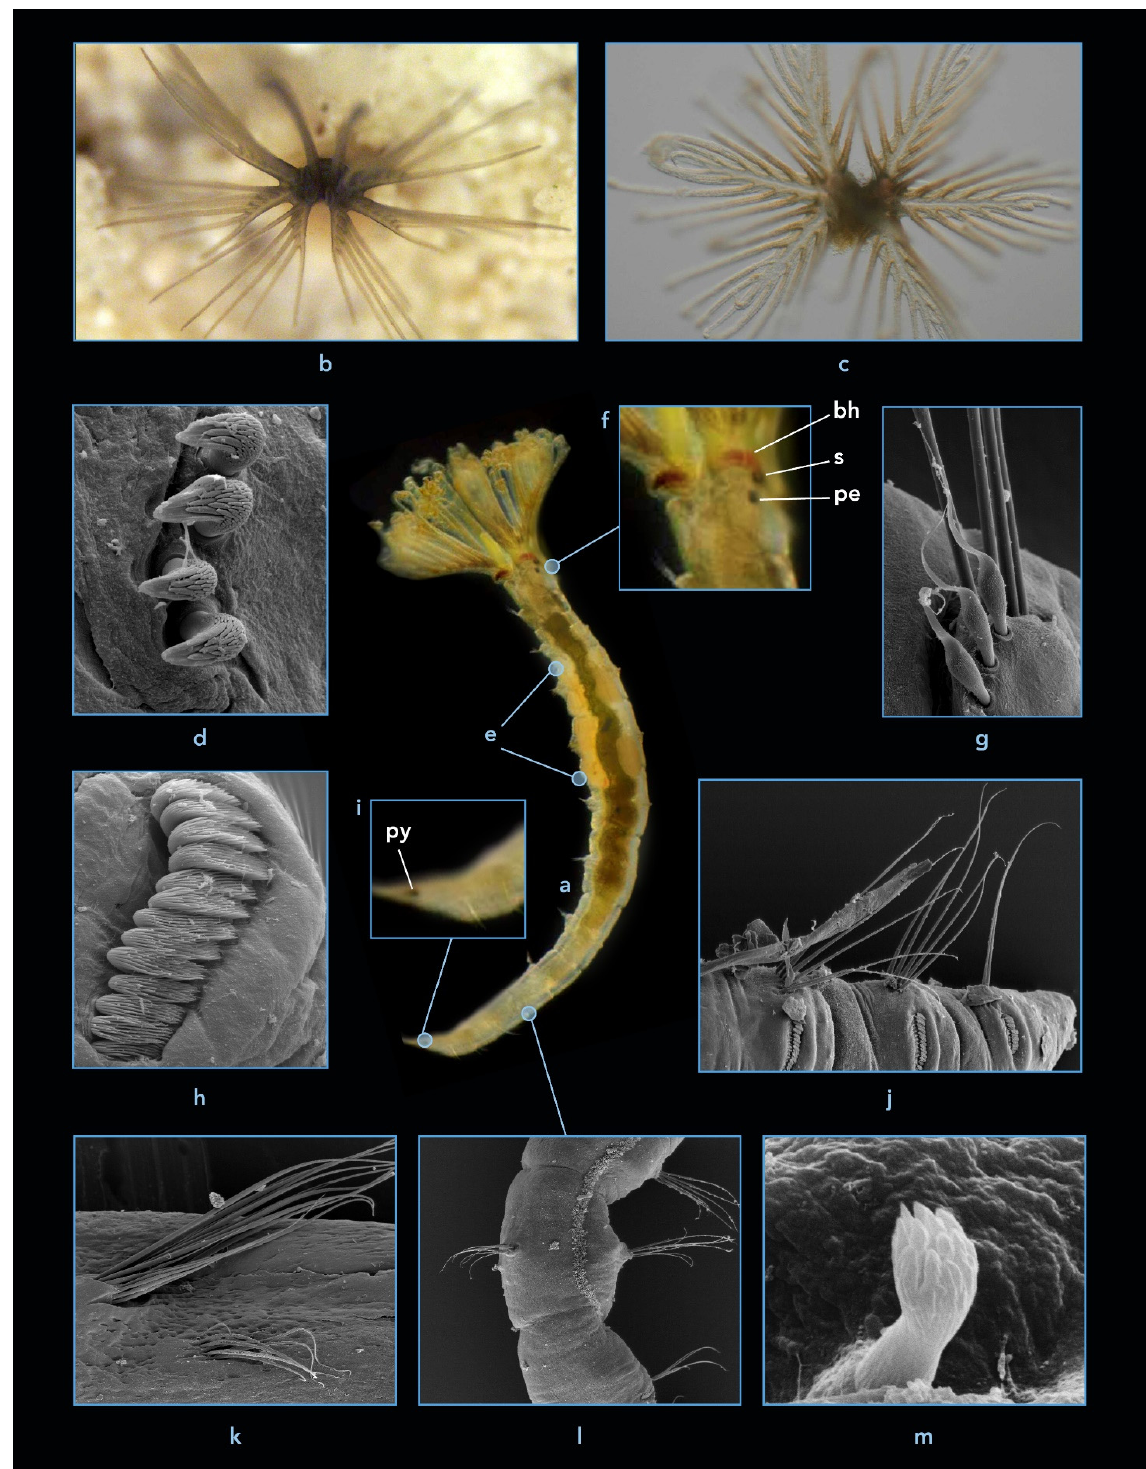
Figure 8. Main diagnostic characters for members of Fabriciidae. ( a ) Fabricia stellaris , dorsal view; ( b ) Pectinated radiolar branching pattern, Manayunkia athalassia ; ( c ) Bi-pectinated radiolar branching pattern, F. stellaris ; ( d ) Thoracic uncini of Manayunkia zenkewitschii ; ( e) Gamete bearing region in thorax; ( f ) Branchial heart (bh), spermathecal (s) and peristomial eye (pe), in this order; ( g ) Thoracic chaetae, M. athalassia ; ( h ) Abdominal uncini, Pseudoaugeneriella nigra ; ( i ) Pygidial eye (py); ( j ) Abdominal chaetae, M. athalassia ; ( k ) Thoracic transitional chaetae (below), Manayunkia godlewskii ; ( l ) Chaetal in- version, M. athalassia ; ( m ) Abdominal pin-ead chaeta, Rubifabriciola tonerella . ( a , c by A. Dietrich; b by G. Christie).